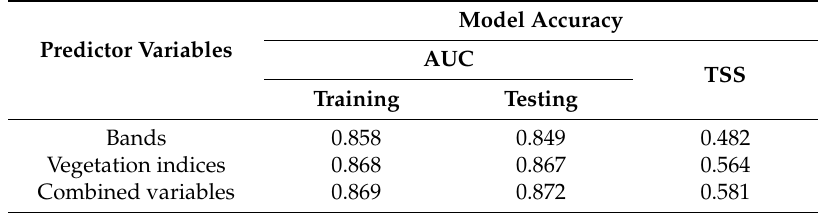
Figure 2. Jack-knife test variable importance graph of ( a ) bands and ( b ) vegetation indices derived in modelling the spatial distribution of C. tristis . Table 5. Evaluation results for all influential predictor variables used for predicting the probability of occurrence of the C. tristis